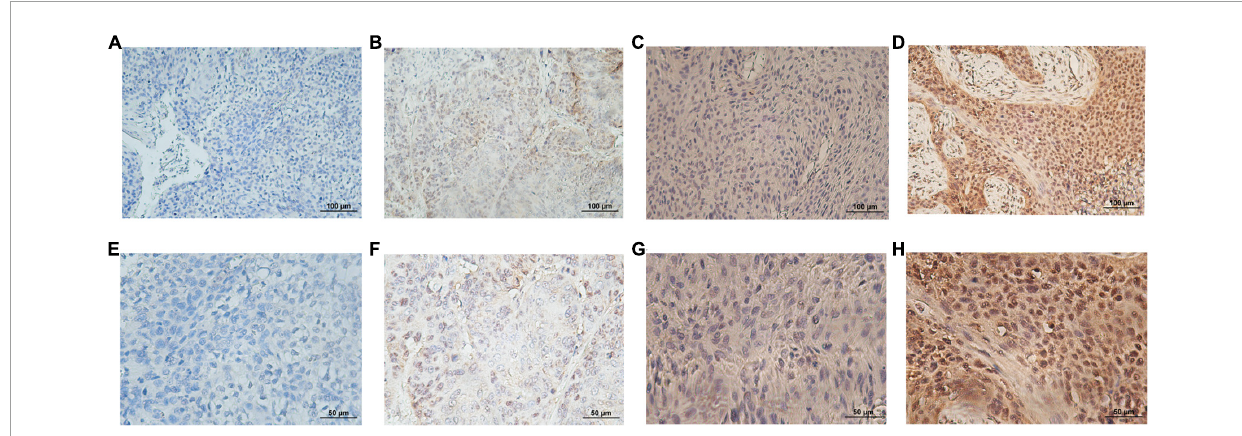
FIGURE1 Representative immunohistological staining for each SMAD4 score. Low expression level of SMAD4 was defined by scores of 0 (A,E) and 1 (B,F) and high expression level of SMAD4 was defined by scores of 2 (C,G) and 3 (D,H) (upper panel, × 200 magnification; lower panel, × 400 magnification).